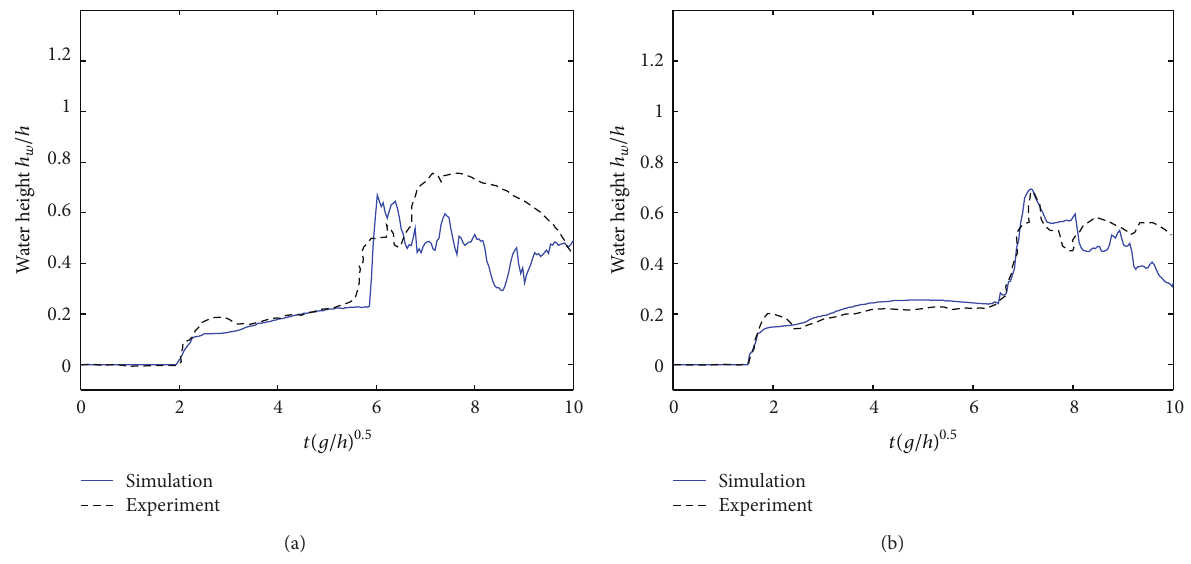
Figure 12: Vertical water heights at two measurement points: (a) H1, (b) H2.